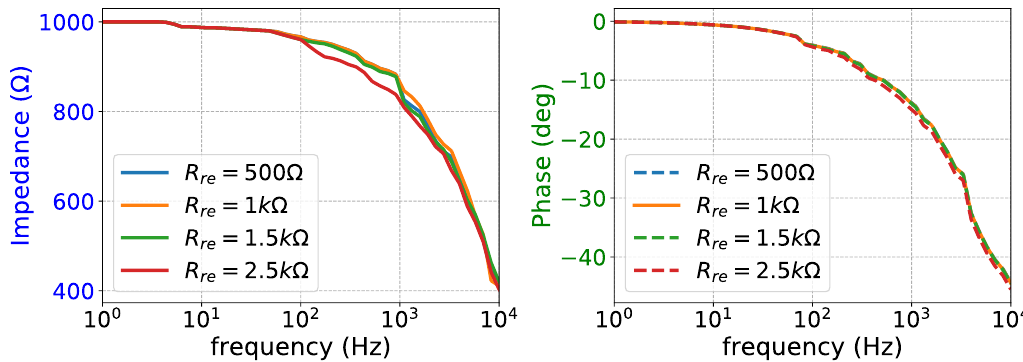
Figure 31. AC magnitude ( left ) and phase ( right ) impedance measurements for deviated shunt impedance of the positive voltage electrode (versatile design).